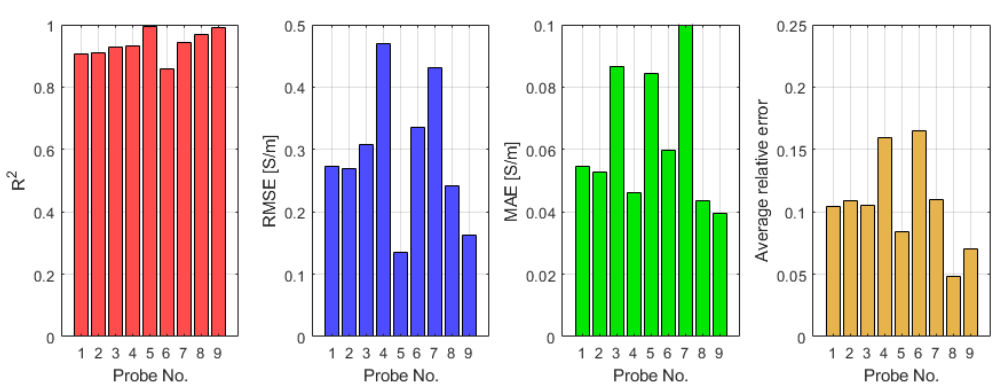
Figure 10. The metrics of